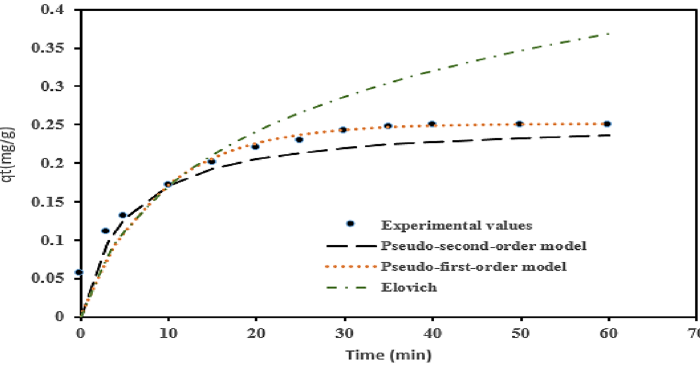
Figure 12. Kinetics plots for COLR removal on AQEF at pH4 and 0.2 g PNSC L −1 .